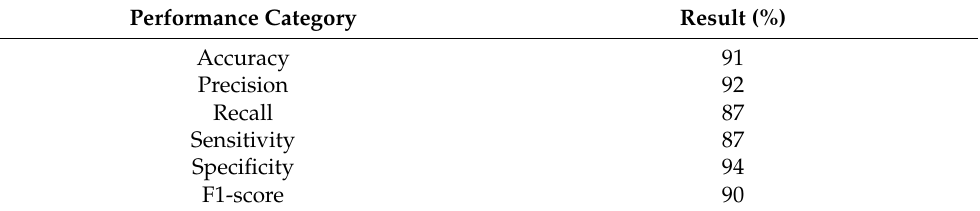
Table 5. Non-COVID-19 Pneumonia CXR Model Performance Table.